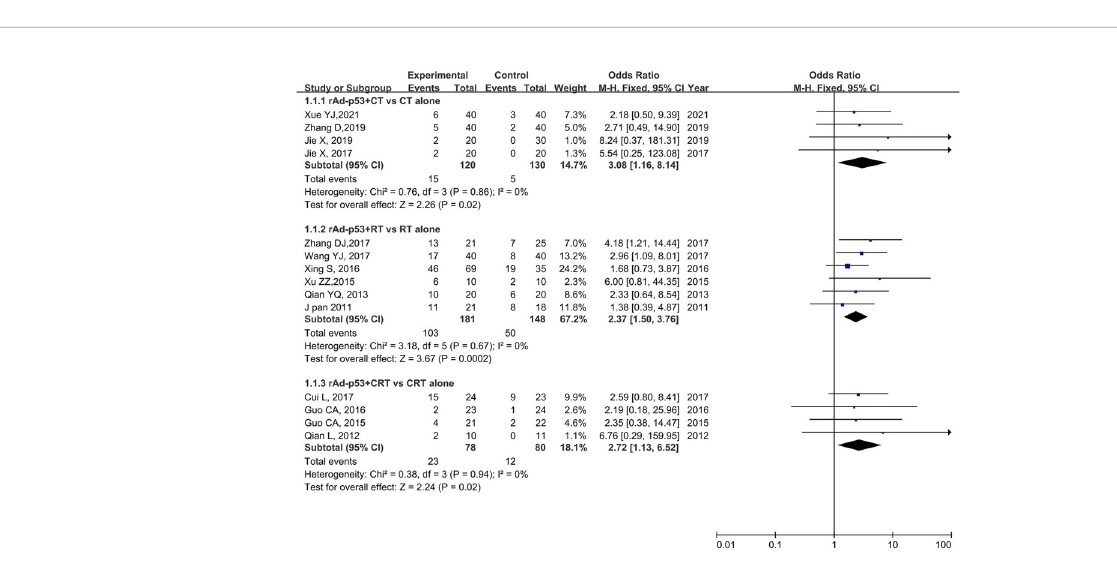
Frontiers in Oncology |